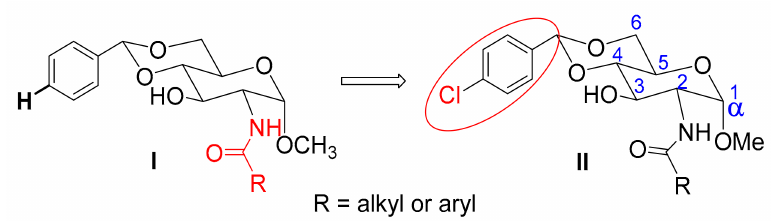
Figure 1. Design rationale of effective sugar-based